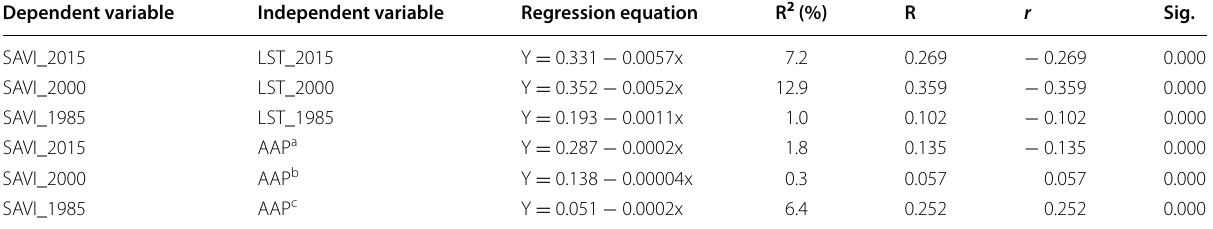
Table 3 Linear regression and correlation coefficients for the relationship between SAVI and LST; SAVI and AAP in 1985, 2000, and 2015 pixel-by-pixel